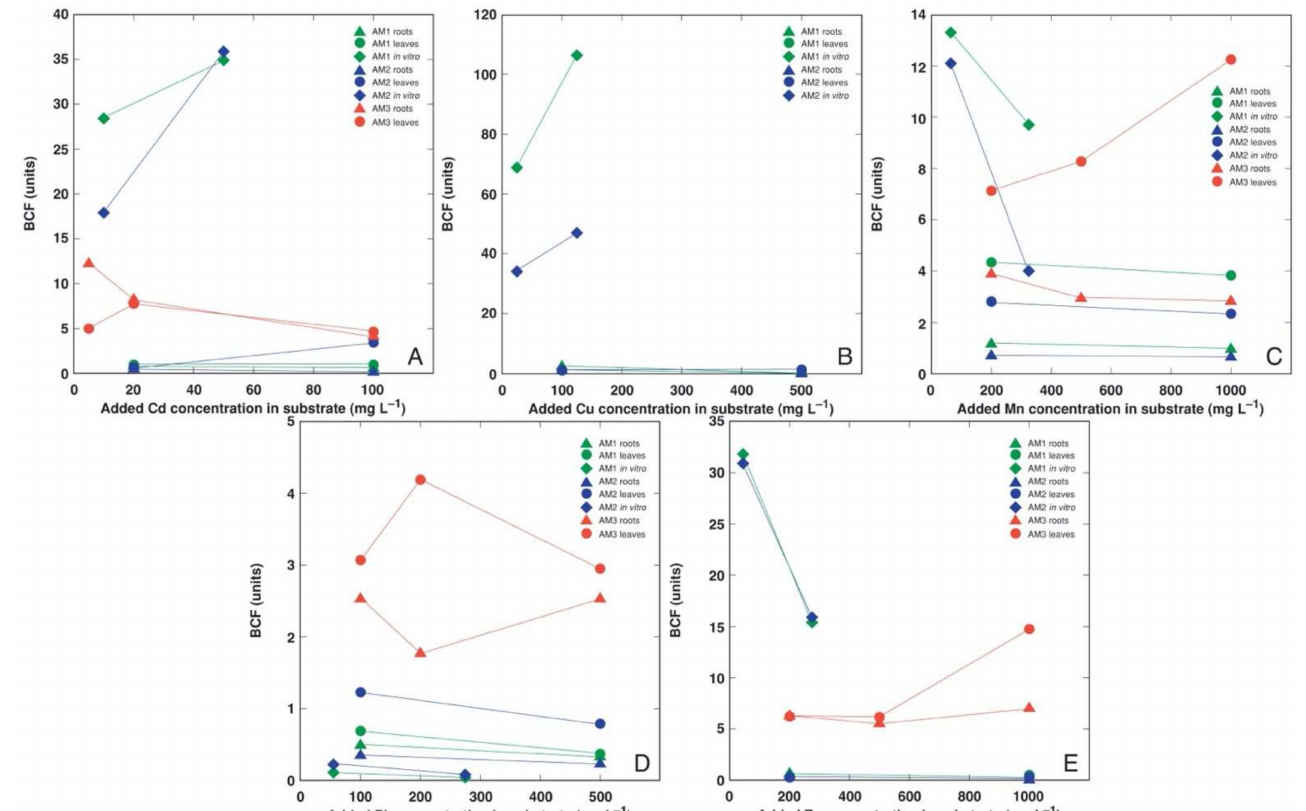
Figure 10. Summary of changes in bioconcentration factor for Cd ( A ), Cu ( B ), Mn ( C ), Pb ( D ), and Zn ( E ) in roots and leaves of Armeria maritima plants from different